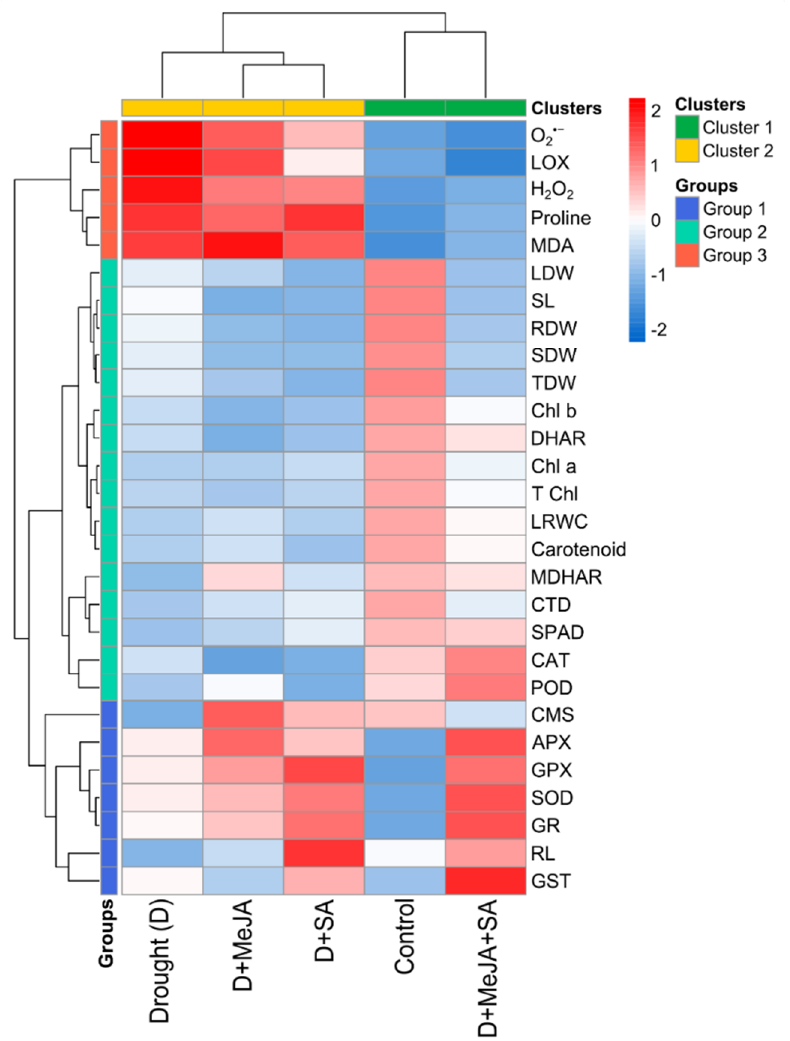
Figure 6. Heatmap and cluster analysis of the growth and physiological attributes, oxidative stress indicators, and antioxidant enzymes in French bean plants grown under control, drought (D), and drought-stressed plants treated with methyl jasmonate (D + MeJA), salicylic acid (D + SA), and their combination (D + MeJA + SA). Additional details are shown in Figure 1.